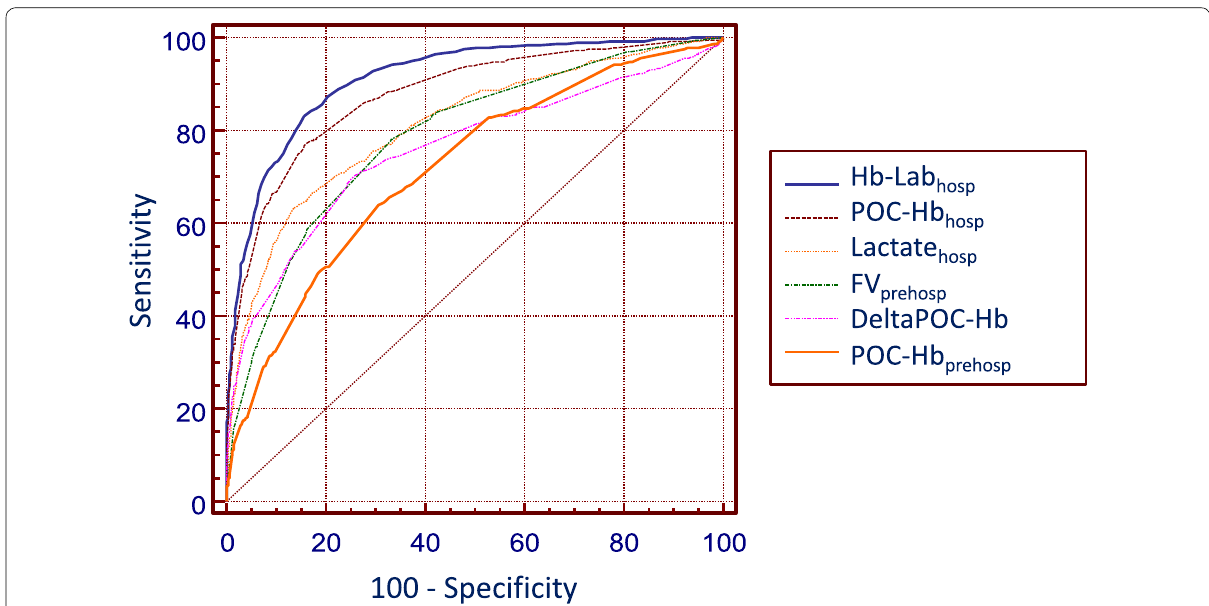
Fig. 2 Receiver operating characteristic (ROC) curves describing the abilities of different parameters to predict significant hemorrhage. Hb-Lab hosp hemoglobin level provided by the laboratory at hospital admission, POC-Hb prehosp and POC-Hb hosp prehospital and hospital hemoglobin levels provided by the point-of-care (POC) HemoCue ® device, DeltaPOC-Hb POC-Hb hosp lactate hosp serum lactate measured at hospital